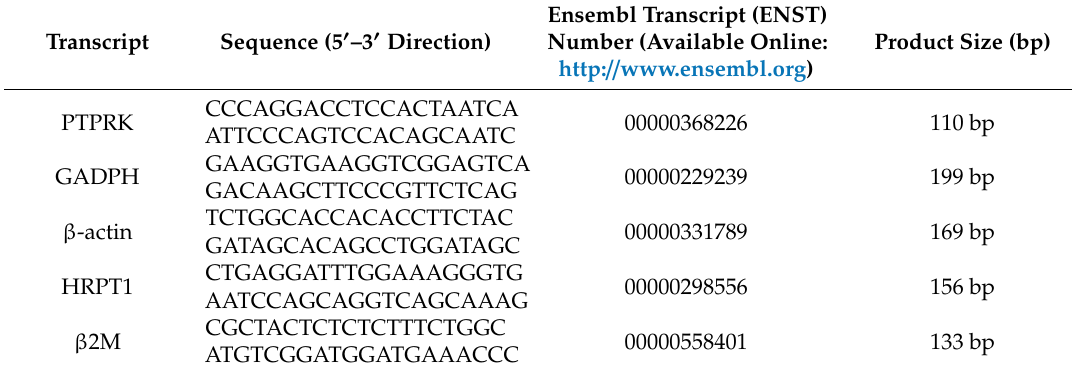
Table 1. Oligonucleotide sequences used for Real-Time Quantitative Polymerase Chain Reaction (RQ-PCR)